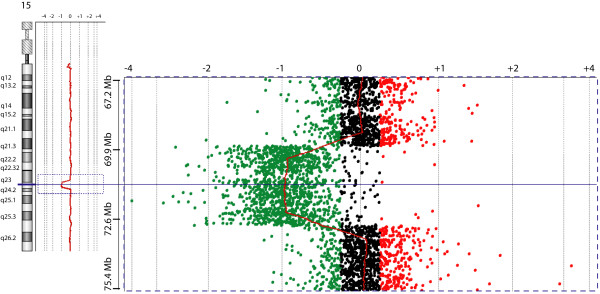
aCGH showing a 3.1 Mb deletion at 15q23-q24.1 in patient AU008. Scatterplot (chromosome view) from the 1 × 1 M array using DNA Analytics software (Agilent Technologies). The X axis represents copy number relative to the control and the Y axis represents location along chromosome 15. The area enclosed by the dashed box adjacent to the chromosome 15 ideogram is enlarged on the right. Green circles indicate probes with a log2 ratio ≤ -0.25, red circles denote probes with a log2 ratio ≥ 0.25; black circles are probes that fall in between these two values.